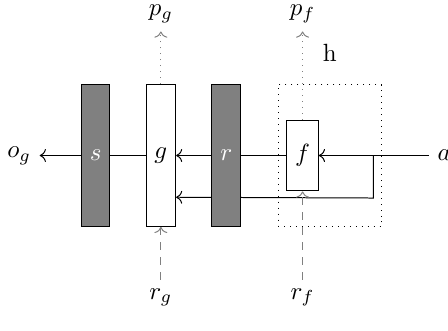
Figure 20: The considered example composition pattern, gray boxes are